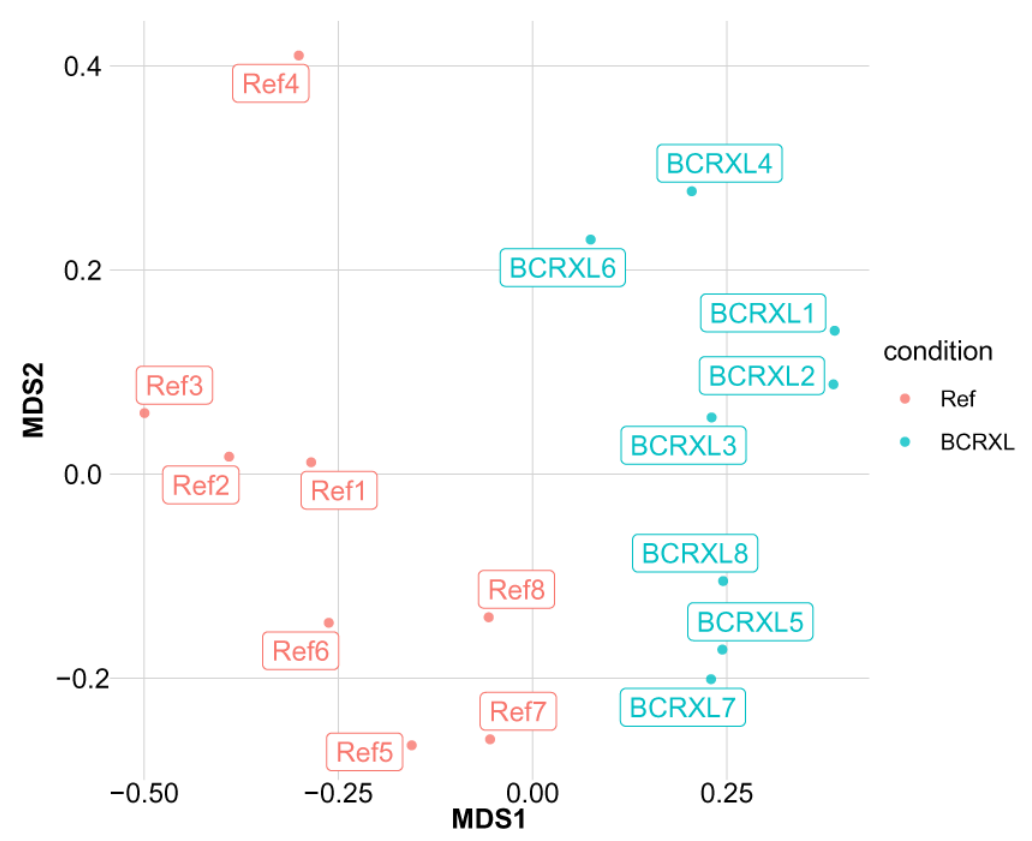
Figure 3. MDS plot for the unstimulated (Ref) and stimulated with BCR/FcR-XL (BCRXL) samples obtained for each of the 8 healthy donors in the PBMC dataset. Calculations are based on the median (arcsinh-transformed) marker expression of 10 lineage markers and 14 functional markers across all cells measured for each sample. Distances between samples in the plot approximate the typical change in medians. Numbers in the label names indicate patient